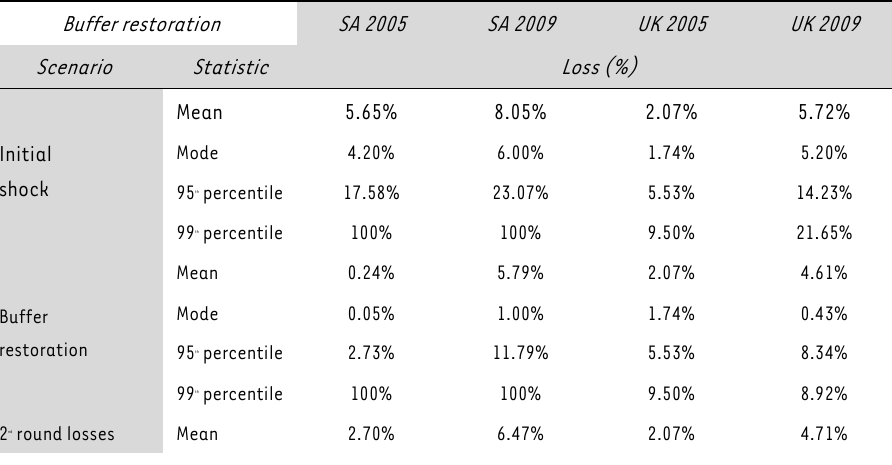
Loss statistics for original LSTs for both economies in both periods Buffer